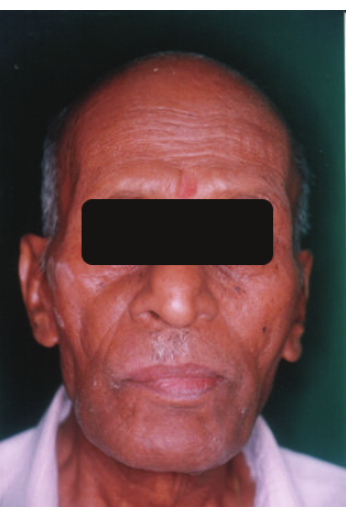
Figure 6: Patient after complete denture